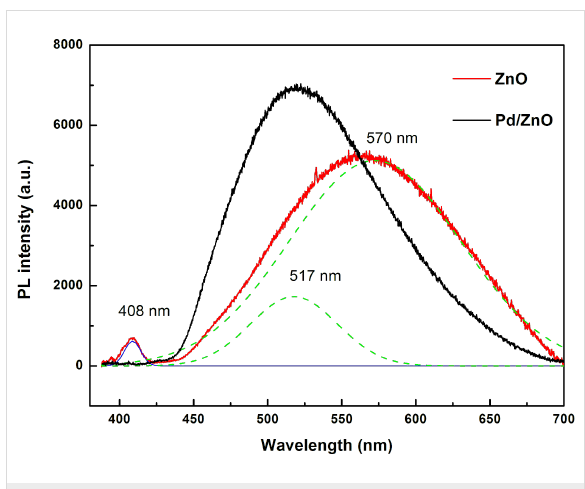
Figure 3: PL spectra of ZnO and Pd/ZnO nanoparticles at room temperature.